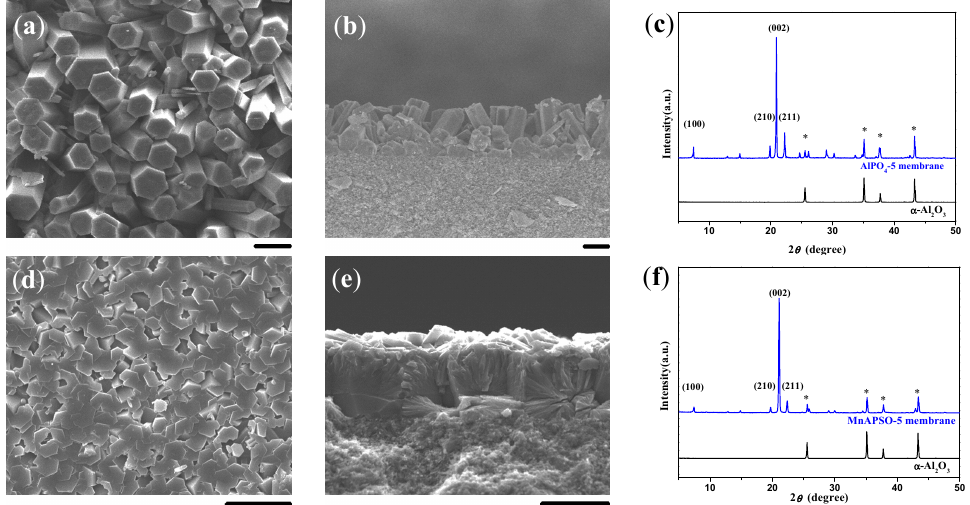
Figure 5. Top view and cross-sectional SEM images together with the corresponding XRD patterns for ( a – c ) AlPO 4 -5 and ( d – f ) MnAPSO-5 membranes induced by a layer of LMW chitosan using AIP as the Al source. Scale bars correspond to 20 µ m in SEM images. The asterisks in the XRD patterns mark the peaks originating from the α -Al 2 O 3 substrate.